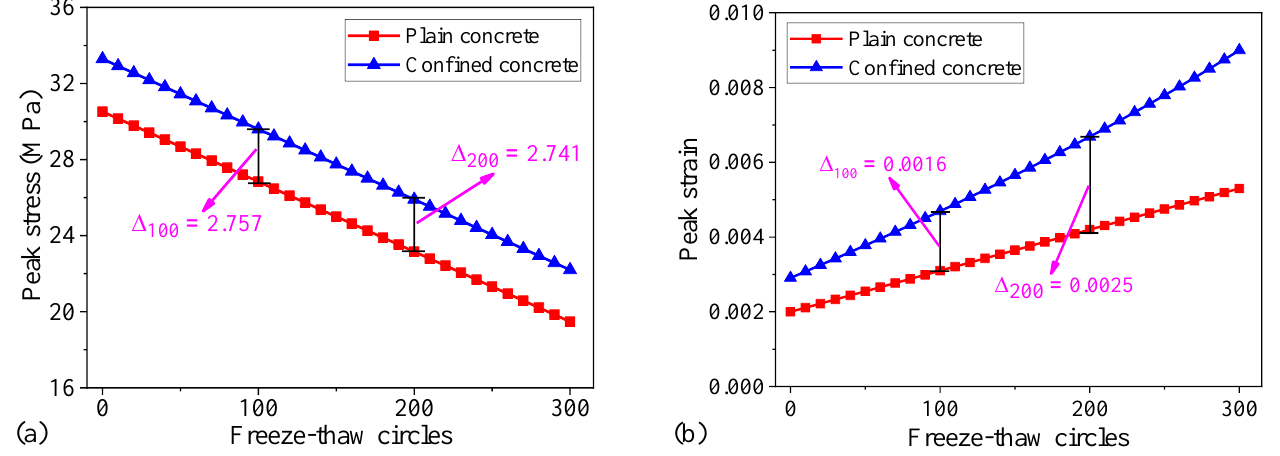
Figure 6. The variations in the constitutive parameters of RC columns under different freeze – thaw